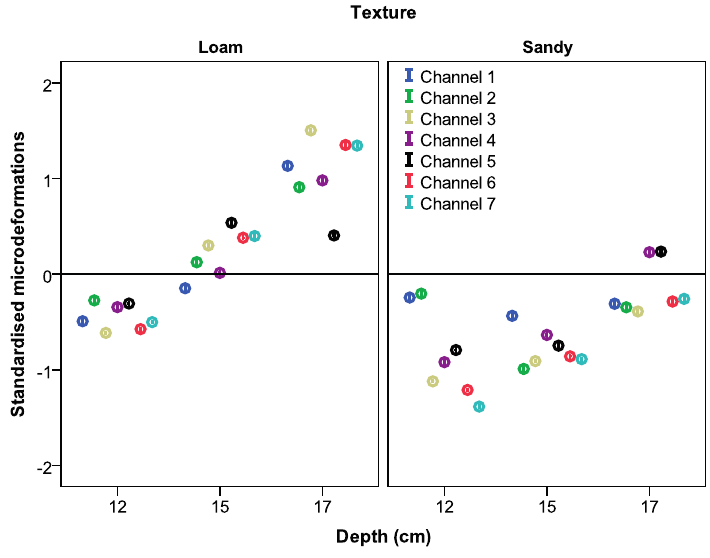
Figure 9. 95% confidence intervals of all micro-strains standardised according to soil texture at different application